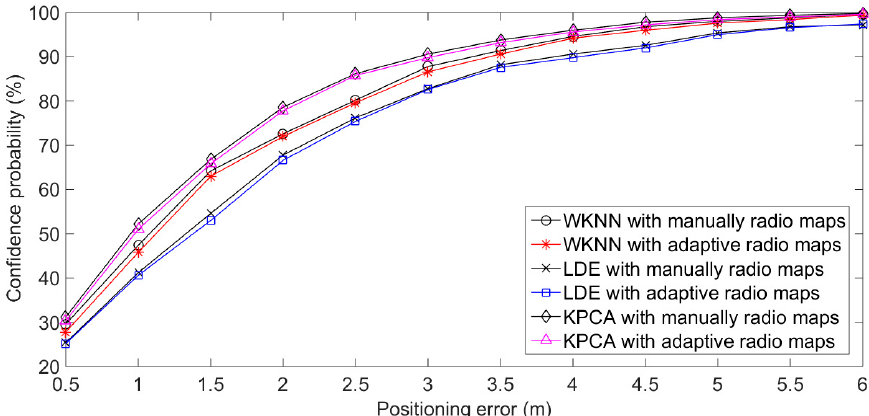
Figure 18. Dynamic positioning results of Experiment 2. Table 2. Positioning error with confidence probability 90% of three algorithms for two different databases in Experiment 2.